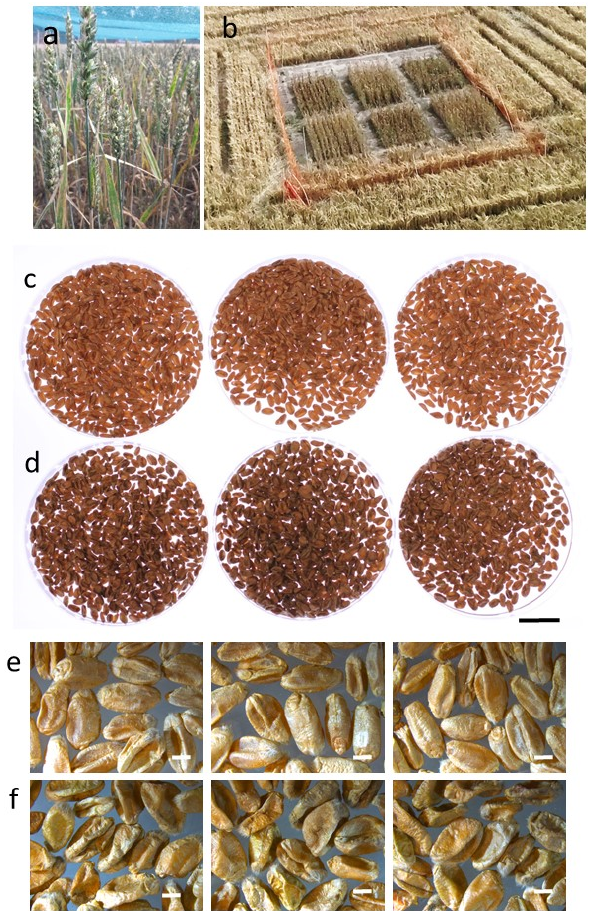
Figure 1. Photos on the field trial of AsWRI1 -wheat and the harvested grain. ( a ) Developing spikes under insect proof net during flowering. ( b ) The field seen from above at grain maturity with the 2.5 m × 1.6 m plots with three replicates each of lines R3P8.12, null (control) and R3P8.10, homozygous with 12 gene inserts. ( c ) Triplicate batches of grains harvested from control and ( d ) R3P8.10 plants, black scale bar is 20 mm. ( e ) Close up photos of triplicate batches of grains from control and ( f ) R3P8.10, white scale bars are 2